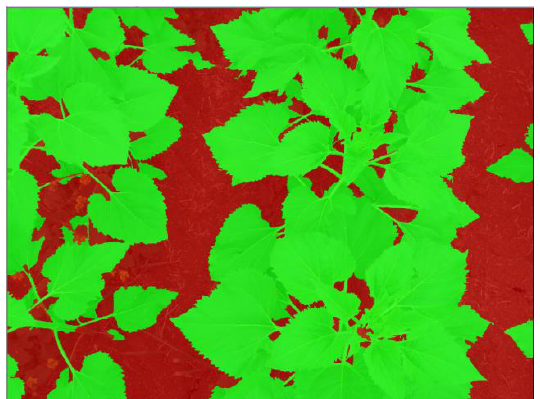
Figure 2. Digital camera images of 2014-23, sunflower plant image classified sunflower and the other materials. In the second method, crop cover fraction estimated with green crop tracker software.